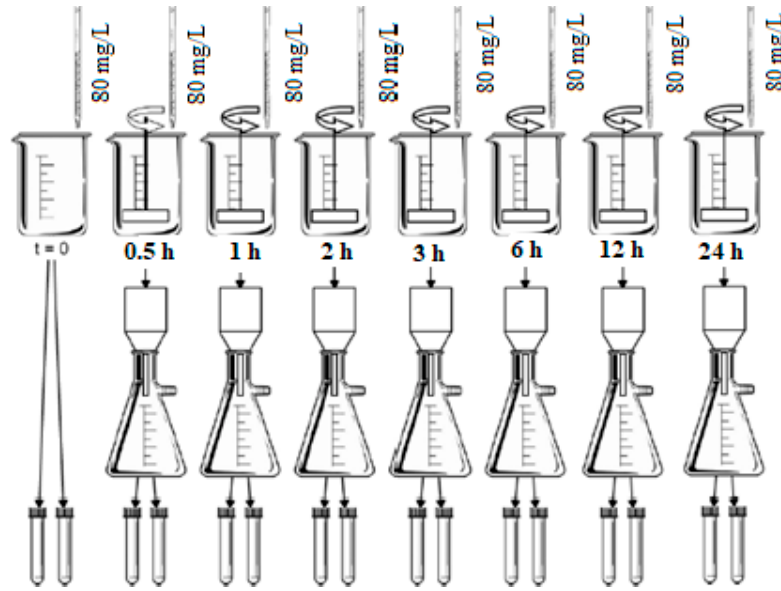
Figure 2. Schematic diagram of the equilibrium time test.